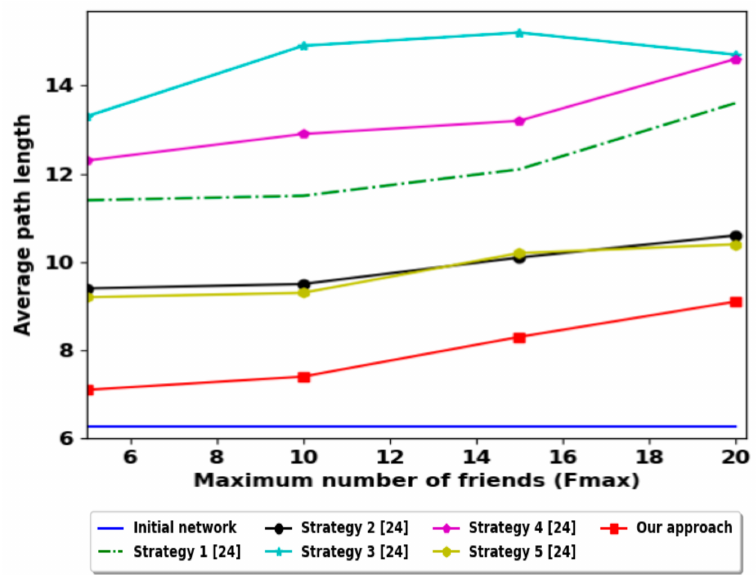
Figure 10. Average path length comparison with other